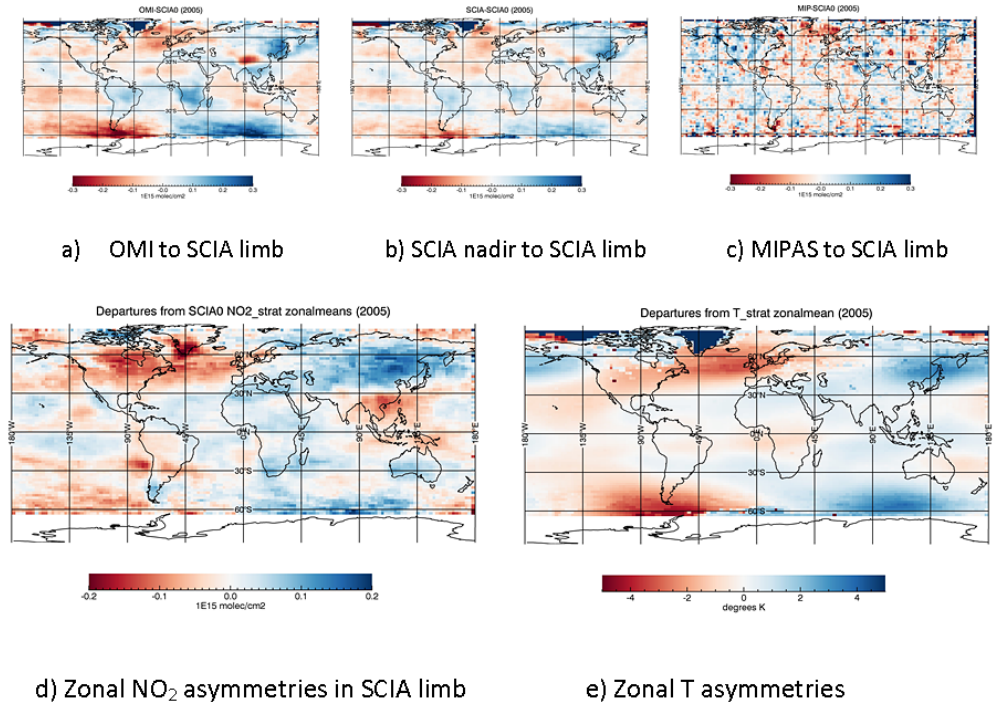
Figure 13. Longitudinal error signatures: annual differences in stratospheric NO 2 for 2005 between (a) OMI and SCIAMACHY limb, (b) SCIAMACHY nadir and SCIAMACHY limb and (c) MIPAS and SCIAMACHY limb, after removal of a latitudinally dependent bias. The lower plot shows geophysical departures of (d) stratospheric NO 2 columns and (e) temperatures from the annual zonal